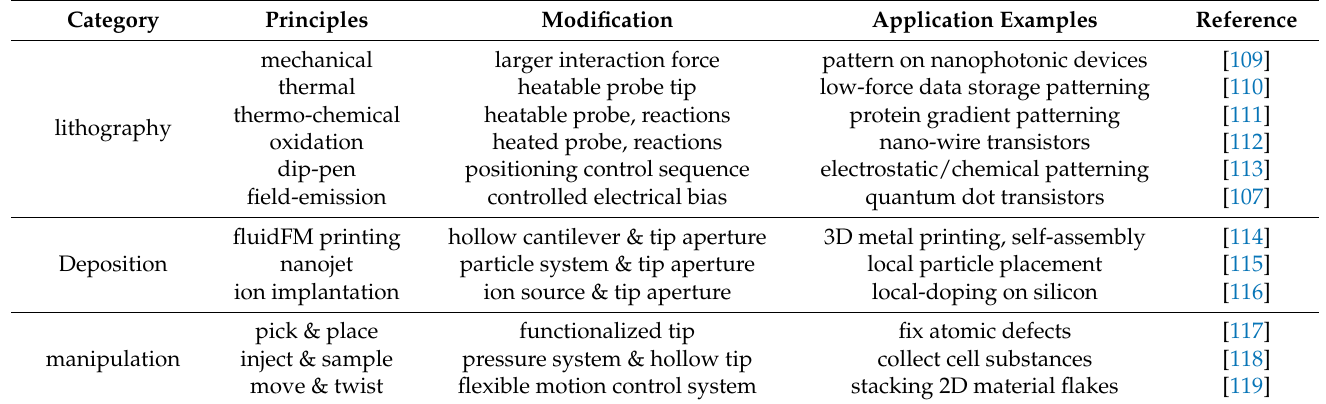
Table 3. AFM Manipulation and Nanofabrication Capability